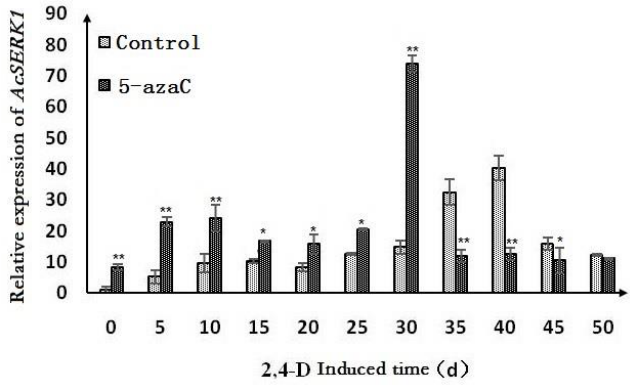
Figure 4. E ff ect of 5-azaC on the expression of AcSERK1 during the process of SE. The data were the average of 3 biological replicates and the error bars denote standard error of the mean. Comparisons between pretreated (5-azaC) or untreated (“Control”—without 5-azaC) at the same induction times. The expression di ff erences with di ff erent treatments were compared using a one-way ANOVA by SPSS 19.0. * p < 0.01 and ** p <